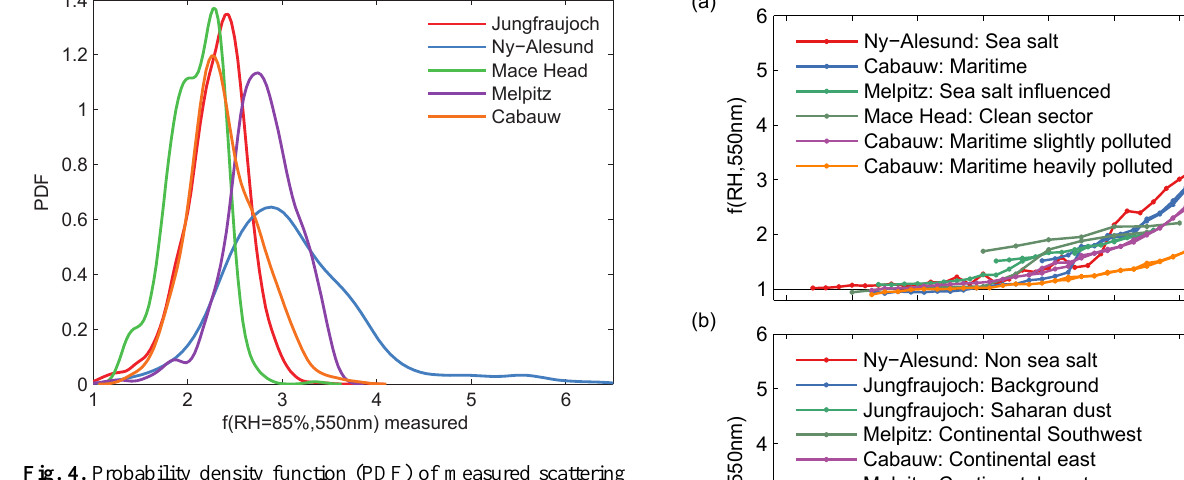
Fig. 4. Probability density function (PDF) of measured scattering enhancement f (RH = 85%, 550nm) at the different sites (see leg- end).